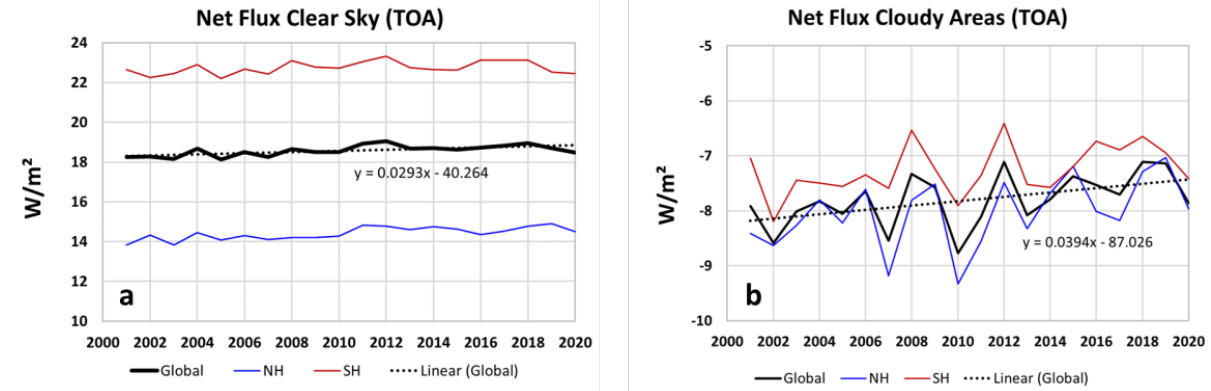
Figure 7. The effective temperature of the clouds is ca. 3.5 K higher in the Southern hemisphere compared with the North. In 20 years, it has increased by ca. 0.1 K in the SH, by ca. 0.2 K in the NH, and by 0.15 K in the global average. The data were downloaded from CERES. Source: https://ceres.larc.nasa.gov/data/ (accessed on 29 July 2021).